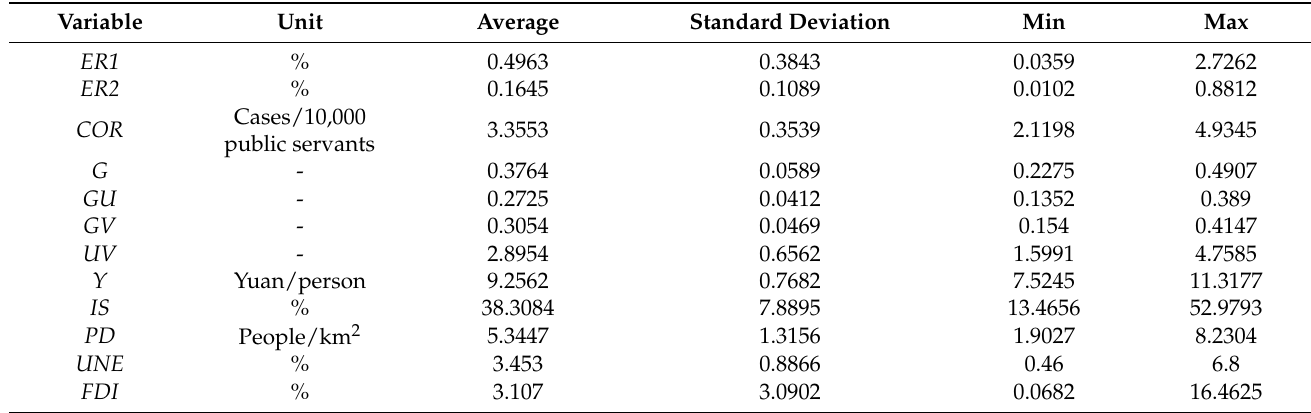
Table 1. Descriptive statistics of variables.